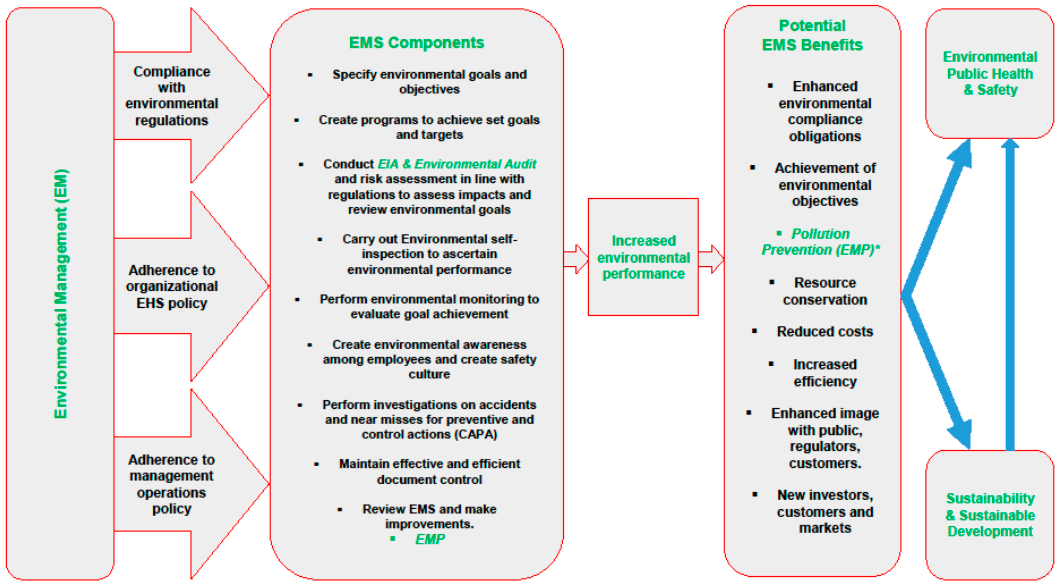
Figure 2. EM/EMS Model. EM—environmental management; EMS—environmental management system; EIA—environmental impact assessment; * EMP—environmental management plan; EHS—environmental health and safety